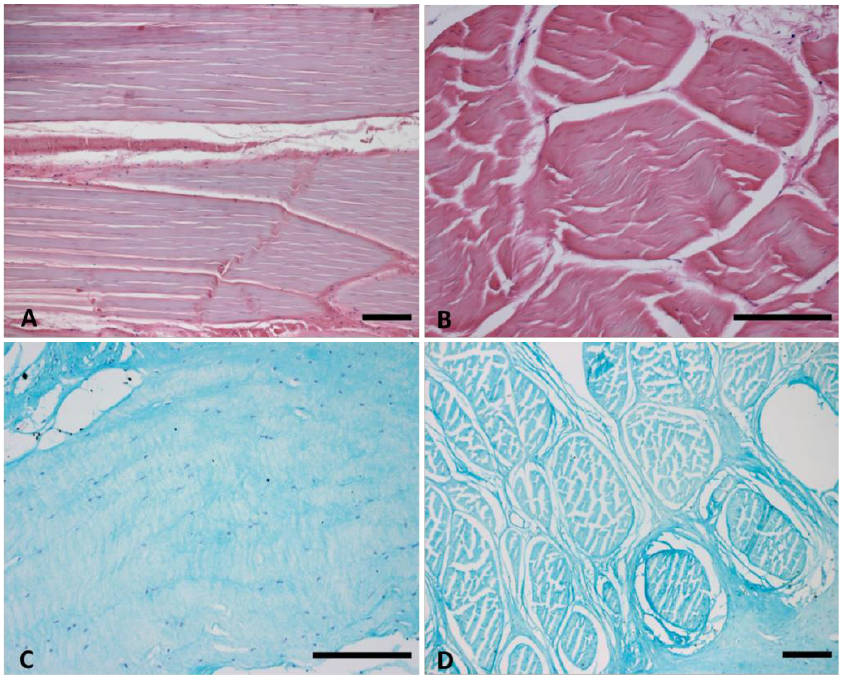
Figure 2. Haematoxylin and eosin ( A , B ) and Alcian Blue ( C , D ) staining in longitudinal ( A , C ) and transversal ( B , D ) directions. Scale Bars: 200 µm. Magnification: ( A , D ) = 5×; ( B , C ) = 10×.